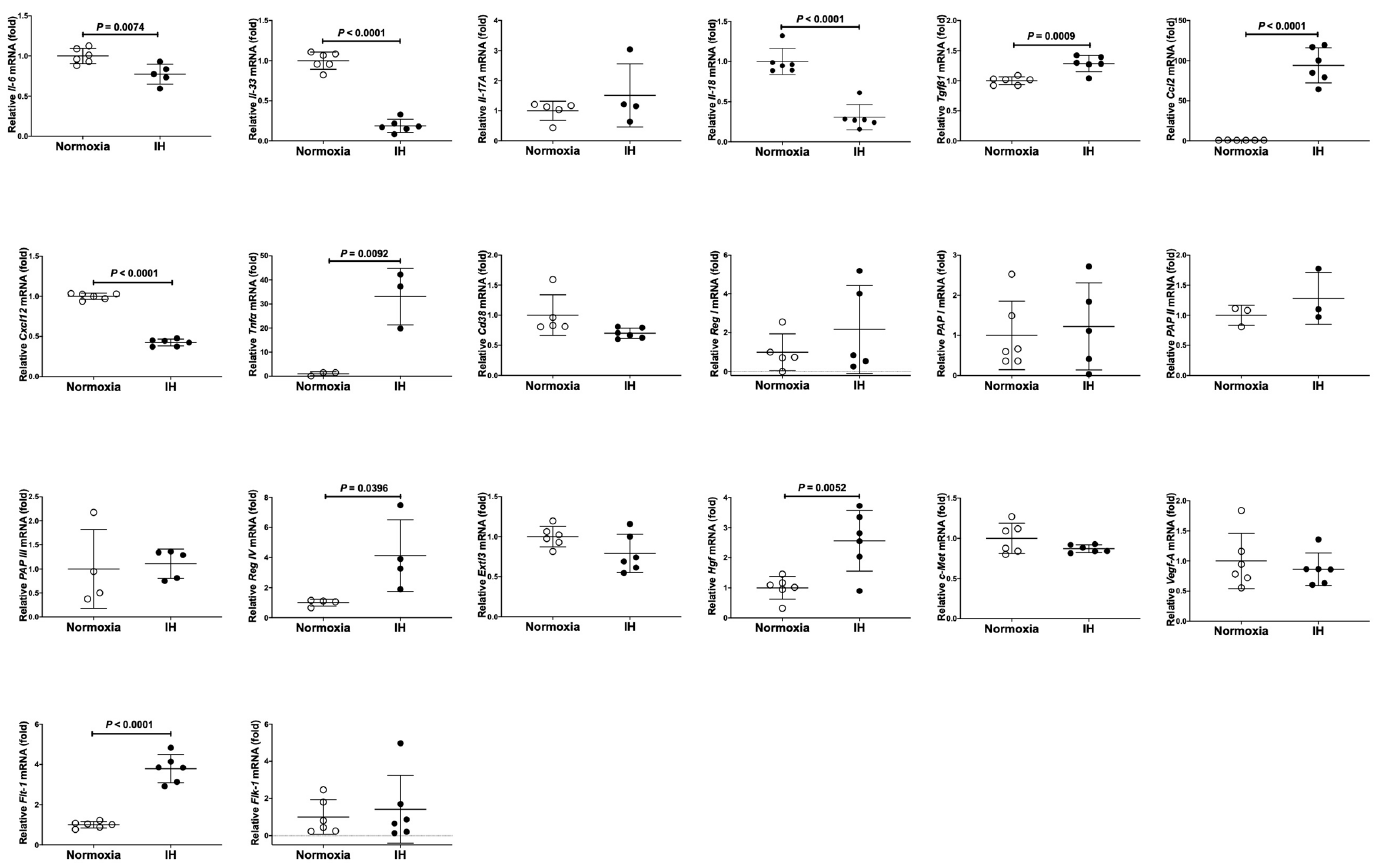
Figure 1. The mRNA levels of rat Il-6 , Il-33 , Il-17A , Il-18 , Tgf β 1 , Cxcl12 , Tnf α , Ccl2 , Vegf-A , Flt-1 , Flk-1 , Cd38 , Reg I , PAP I , PAP II , PAP III , Reg IV , Extl3 , Hgf , and c-Met in rat H9c2 cardiomyocytes. Rat H9c2 cells were treated with normoxia or IH for 24 h. The mRNA levels were measured by real-time RT-PCR and normalized by rat insulinoma gene ( Rig ) /ribosomal protein S15 ( RpS15 ) as an internal standard. The mRNA levels exposed to normoxia were set to 1.0. Open and closed circles indicate values of relative mRNA expression of cells exposed to normoxia and IH, respectively. Data are expressed as the mean ± SD of the samples. Statistical analyses were performed using Student’s t -test. IH significantly increased the mRNA levels of Tgf β 1 , Tnf α , Ccl2 , Flt-1 , Hgf , and Reg IV in rat H9c2 cells. IH significantly decreased the mRNA levels of Il-6 , Il-33 , Il-18 , and Cxcl12 in rat H9v2 cells. The other gene expressions ( Il-17A , Cd38 , Reg I , PAP I , PAP II , PAP III , Extl3 , c-Met , Vegf-A , and Flk-1 ) did not show significant changes.